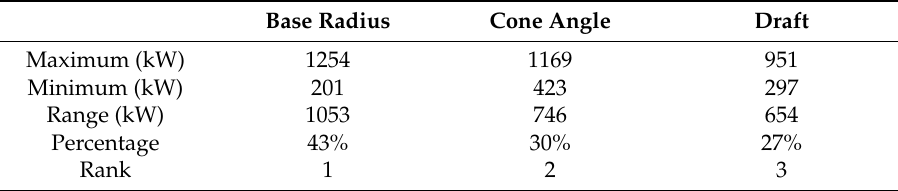
Table 8. Influence degree of geometric parameters on maximum absorbed power.